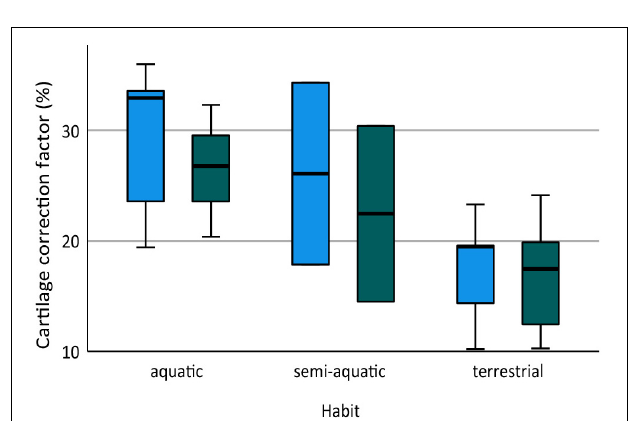
FIGURE 3 | Box plot showing cartilage correction factors (CCF) for the humerus and femur in aquatic, semi-aquatic, and terrestrial salamanders. CCF was calculated as the sum of the proximal and distal cartilage thickness divided by the length of the bony